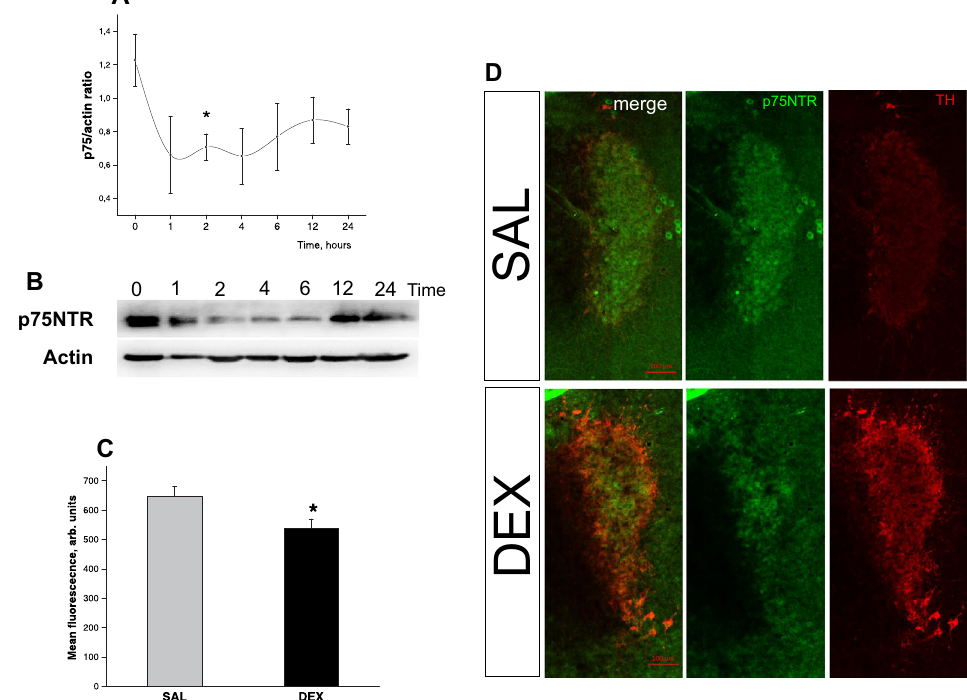
Figure 3. P75NTR protein level changes in the brainstem after single DEX injection 0.2 mg/kg to P2 rat pups. ( A ) p75NTR protein level timeline profile ONE WAY ANOVA, * p < 0.05 compared to the control group, Data are presented as M ± SE ( B ) representative western blot image, (original images are in Supplementary material), ( C ) Immunohistochemistry results.Mean p75NTR fluorescence intensity in norepinephrine LC neurons. ONE WAY ANOVA, * p < 0.05 compared to the control group, Data are presented as M ± SE ( D ) representative micro- photographs of p75NTR (green, Alexa 488) protein level changes in LC norepinephrine neurons(red, Alexa 568) after DEX administration. P75NTR—green (Alexa 488), Tyrosine Hydroxylase (TH)—red (Alexa 568), scale bar—100